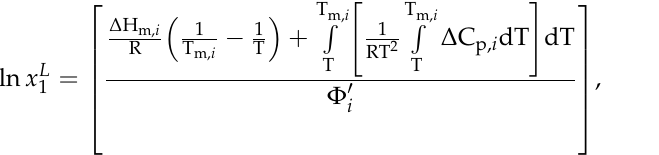
Table 7. The calculated data to confirm the presence of the liquidus line loop using the Fe-Fe 2 Ti iron side by Equation (7). T, K a L